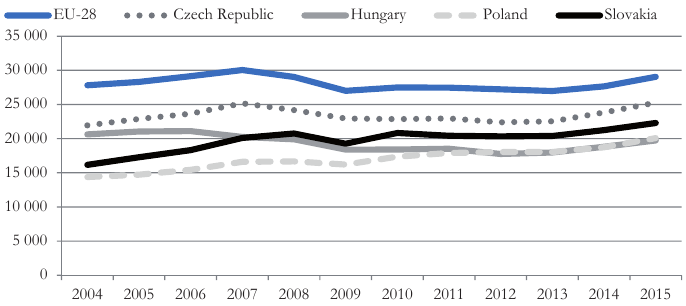
Fig. 1 – GDP pc 2004 – 2015 in the Visegrad countries. Source: Own calculations based on Eurostat database (access: